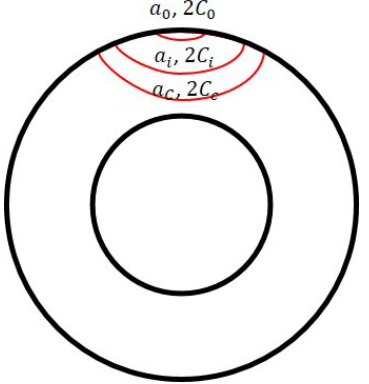
Figure 5. Diagram of a surface crack penetrating the wall.